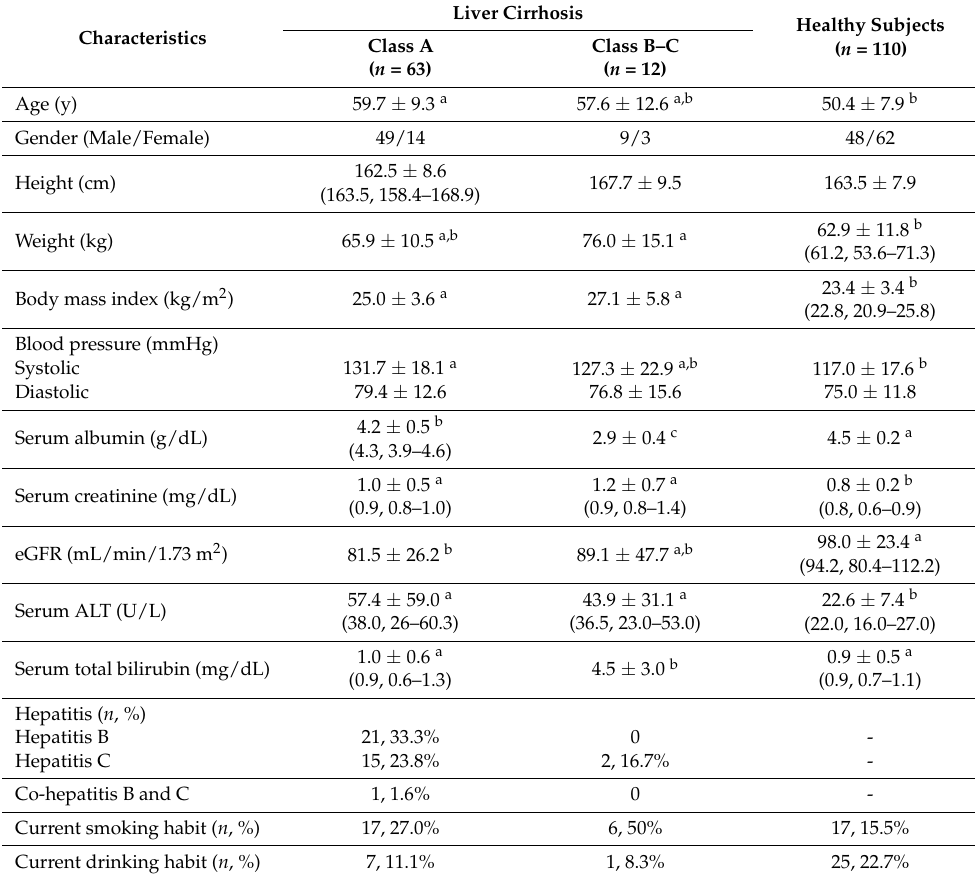
Demographic and biochemical characteristics of patients with liver cirrhosis and healthy